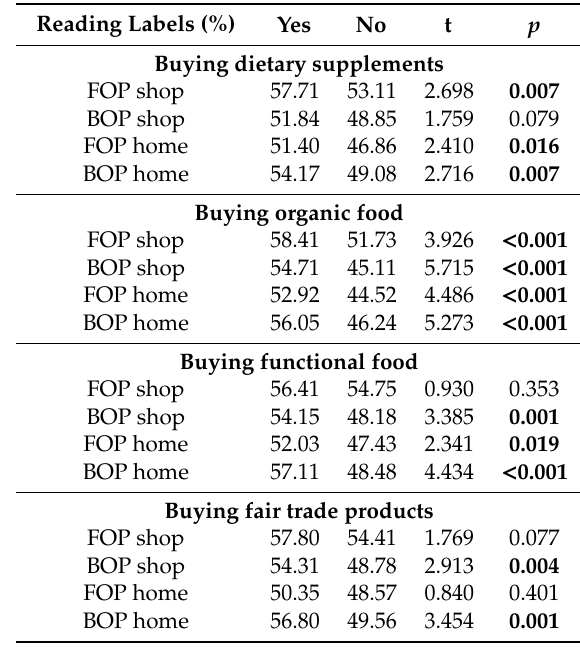
Table 8. Reading food labels by purchasing certain products.